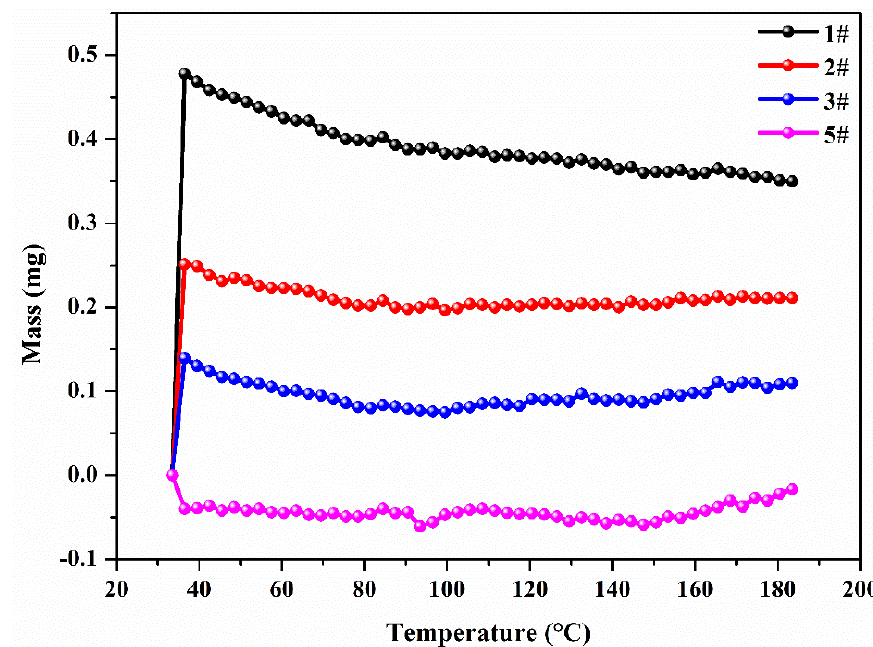
Figure 6. TG difference spectrum curve of coal sample.